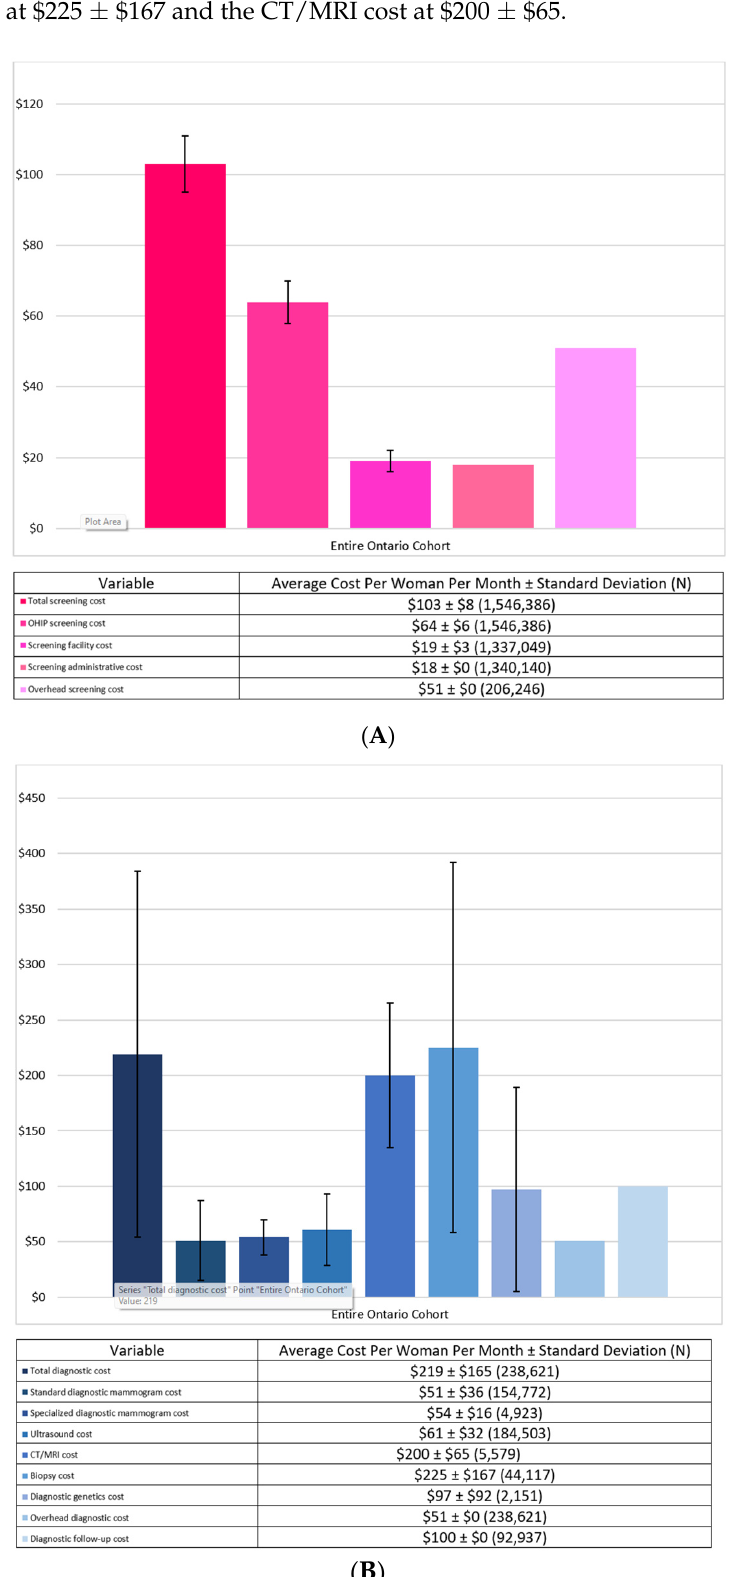
Figure 2. ( A ) Average Screening Costs Per Woman Per Month for the Entire Ontario Cohort. ( B ) Av- erage Diagnostic Costs Per Woman Per Month for the Entire Ontario